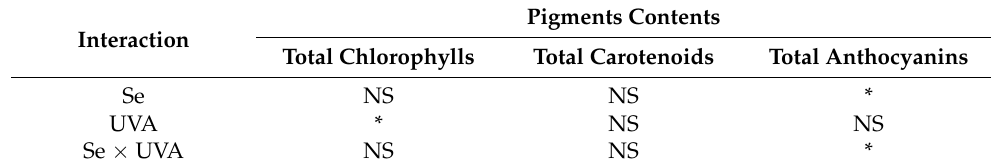
NS and * represent nonsignificant or significant at p < 0.05, according to two-way ANOVA.